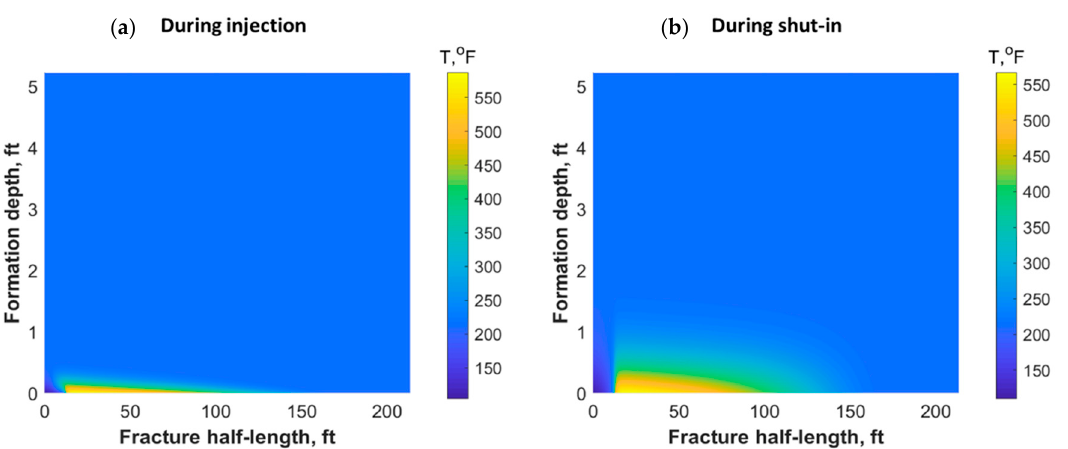
Figure 11. Reservoir temperature profile during ( a ) 30 min of TC injection and ( b ) after 7 h of shut-in.